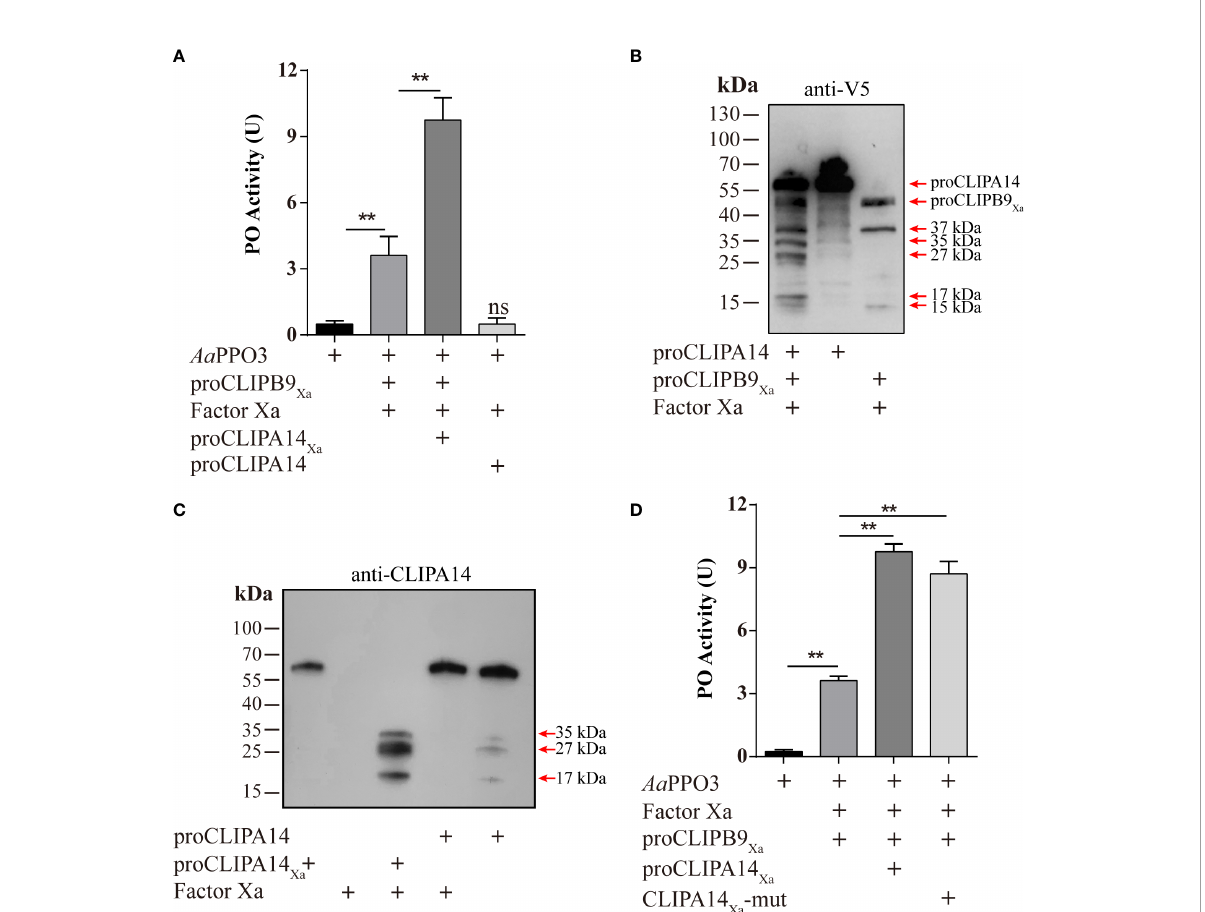
FIGURE 5 Ae. aegypti CLIPA14 treatment signi fi cantly increased the PO activity. (A) Enhancement of PPO3 activation by CLIPA14. proCLIPB9 Xa or its mixture with proCLIPA14 Xa was treated with Factor Xa and then incubated with 300 ng PPO3 prior to PO activity measurement. (B) The cleavage of proCLIPA14 by activated CLIPB9 Xa was detected by immunoblotting. Factor Xa-treated CLIPB9 Xa was incubated with proCLIPA14 (100 ng) and the mixture and controls were analyzed by immunoblotting using anti-V5 antibody. (C) The cleavage of puri fi ed proCLIPA14 Xa by Factor Xa was detected by immunoblotting. After incubation of Factor Xa with proCLIPA14 (100 ng) or proCLIPA14 Xa (100 ng), the mixture was immunoblotted with anti-CLIPA14 antibody. (D) The CLIPA14 Xa -mutant can also act as a cofactor to increase PO activity. ProCLIPB9 Xa , proCLIPA14 Xa , and proCLIPA14 Xa -mutant were activated by Factor Xa and then incubated with PPO3. Using dopamine as the substrate to measure PO activity. CLIPA14 Xa -mut, CLIPA14 Xa -mutant. The bars represent the mean ± SEM (n = 3). **P < 0.01; ns, P >